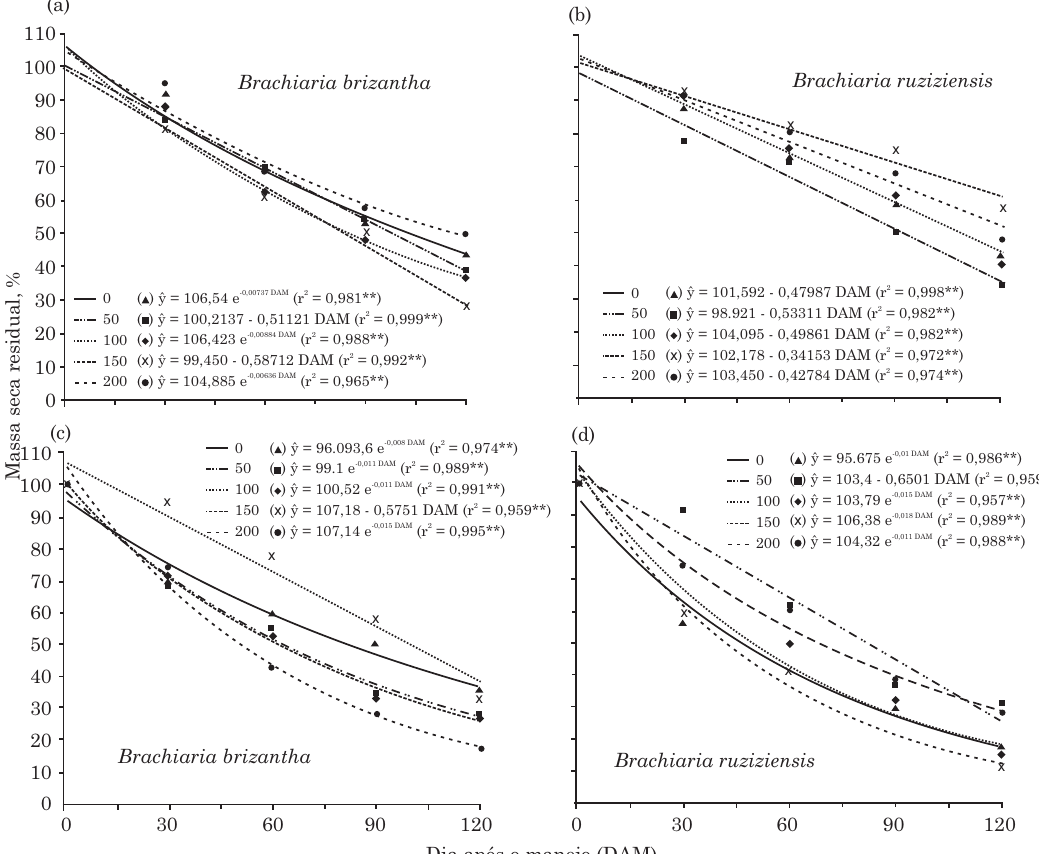
Figura 3. Percentual da massa seca residual (palhada) das espécies de Brachiaria após a dessecação e o manejo de corte, em função da adubação nitrogenada, em que (a) e (b) são safras de 2008/2009; e (c) e (d), safras de 2009/2010. ** : significativo a 1 % pelo teste